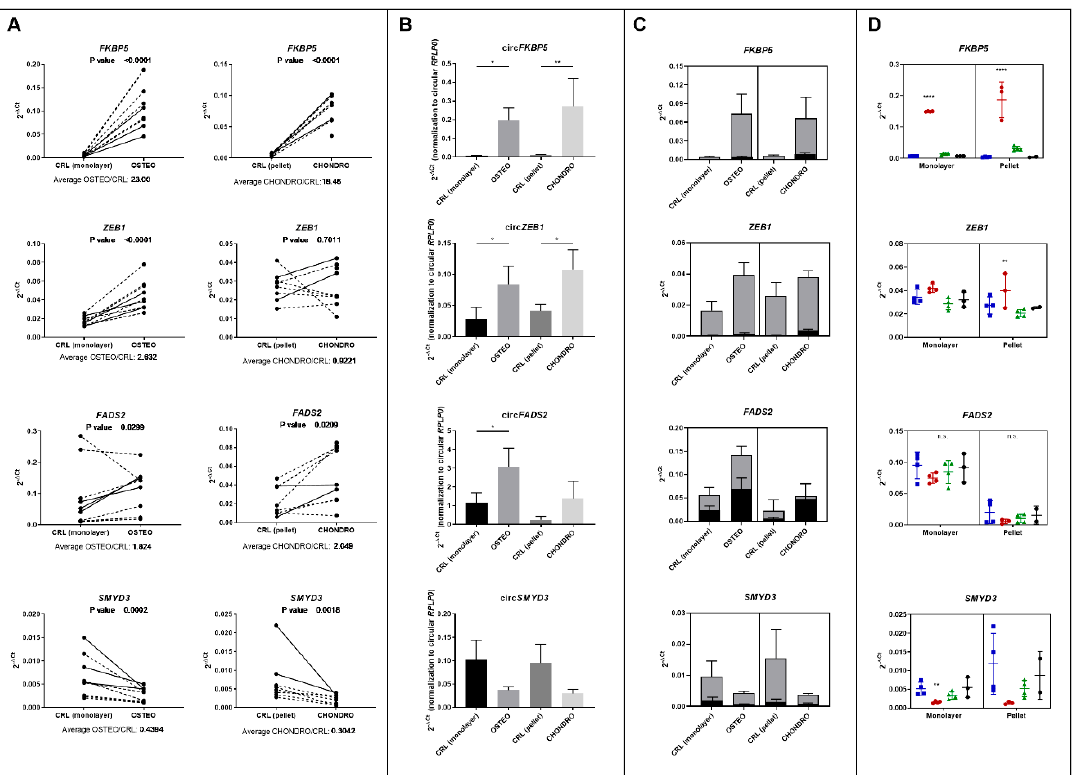
Figure 2. ( A ) Validation of total gene expression levels ( n = 9) corresponding to di ff erentially expressed circular RNAs in both osteogenic (left) and chondrogenic di ff erentiation (right). Full lines represent results from the donors used for microarray ( n = 3), while dashed lines correspond to additional donors tested ( n = 6 for osteogenic and n = 6 for chondrogenic di ff erentiation). For each gene of interest (GOI), the results are shown as 2 − ∆ Ct , where ∆ Ct is calculated as the di ff erence between GOI and reference gene ( RPLP0 ) Ct values. The p -value and the average fold change between day 7 di ff erentiation and day 7 controls are reported for each gene. ( B ) The expression of the same genes was tested after RNase R treatment ( n = 3 donors) to validate the di ff erential expression of the circular RNA. The expression of circular forms of genes was normalized to RPLP0 analyzed in RNase R treated samples (circular RPLP0 ). ( C ) Proportion of circular transcripts on overall gene expression. The grey bar indicates the total amount of transcript for each gene, the black bar shows the amount of circular RNA. For this purpose, both circular and total transcripts were normalized to total RPLP0 ( n = 3 donors). ( D ) E ff ect of dexamethasone on the expression of total FKBP5 , ZEB1 , FADS2 , and SMYD3 in monolayer or pellet cultures. Blue bars and symbols: negative control (no treatment); red: dexamethasone treatment (10 nM in monolayer, 100 nM in pellet culture); green: ( + )-ZK216348 treatment (10 nM in monolayer, 100 nM